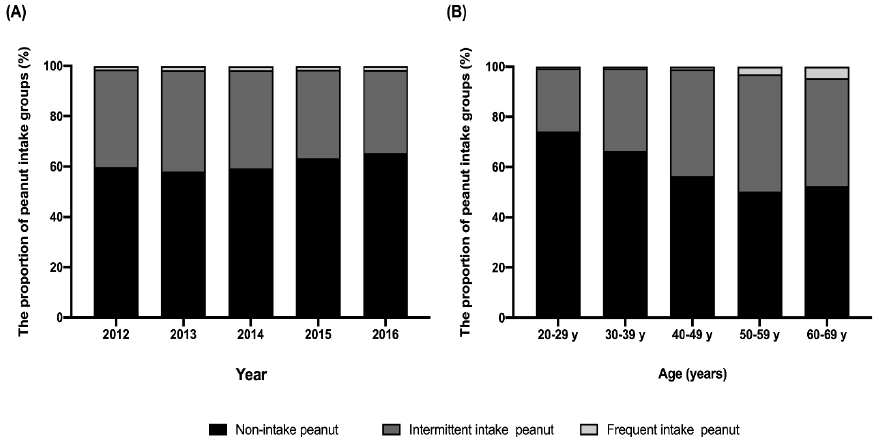
Figure 2. Trend in peanut intake by year and age groups in Koreans. ( A ) The weighted proportion of the non-intake group increased by year, and that of the frequent intake group was relatively constant ( p for trend <0.001). ( B ) The weighted percentage of the non-intake group showed a declining trend based on older age, while that of the frequent intake group increased with older age ( p for trend < 0.001).